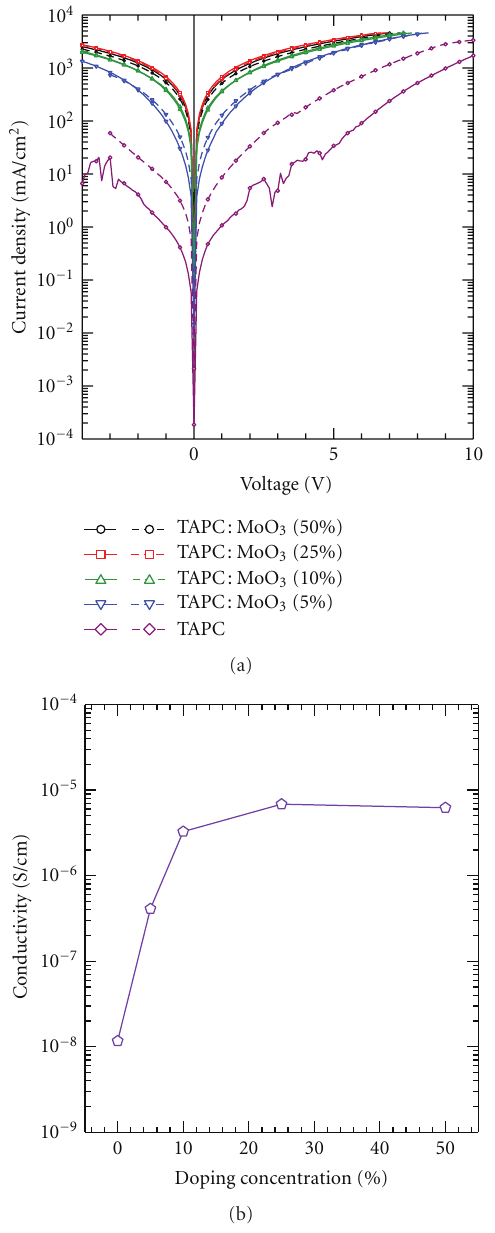
Figure 2: (a) Current density-voltage ( J - V ) characteristics of the hole-only devices with di ff erent MoO 3 concentrations (solid line: without MoO 3 (5nm) layer in both electrodes; dashed line: with MoO 3 (5nm) layer in both electrodes); (b) electrical conductivities of MoO 3 -doped TAPC films with di ff erent doping